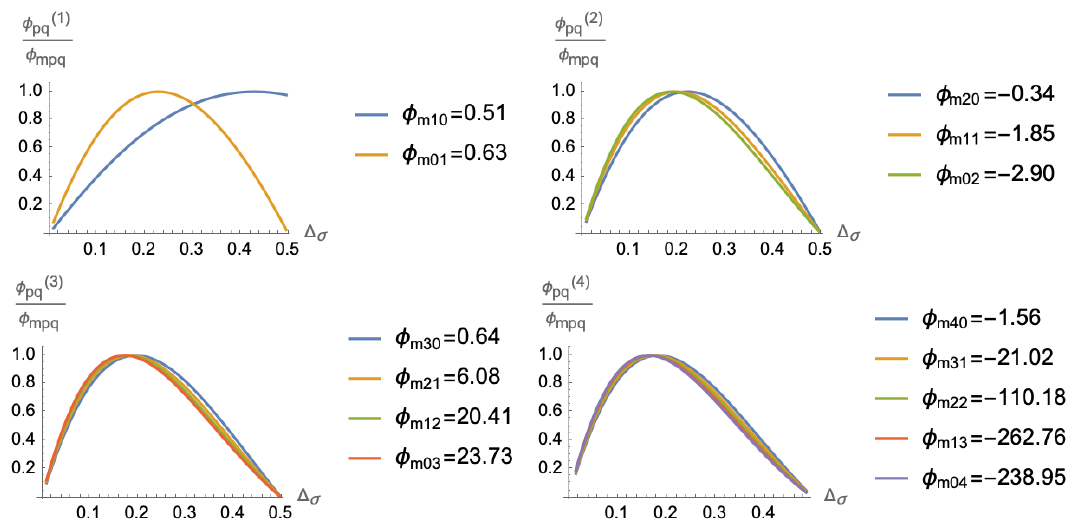
Figure 1: Plots of Wilson coefficients for minimal models described in the text. We have normalized appropriately as indicated in the legends for